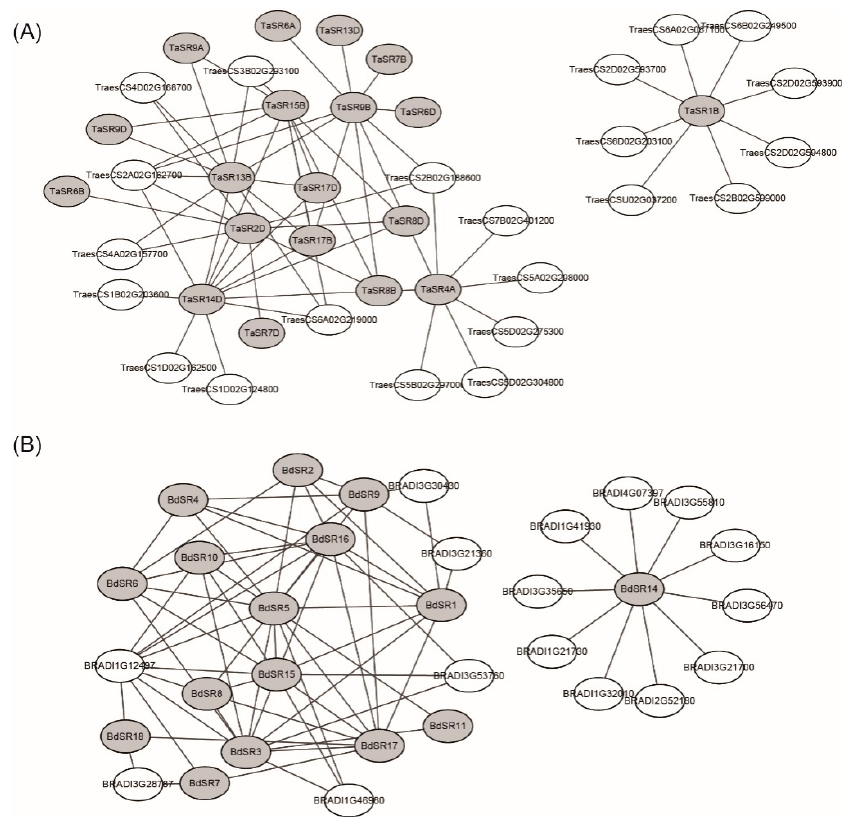
Figure 5. Protein–protein interaction network of ( A ) TaSR and ( B ) BdSR proteins. The gray elliptical represent the TaSR or BdSR proteins, the white elliptical represent the other wheat or B. distachyon proteins, and the black lines represent the interaction relationship between proteins.